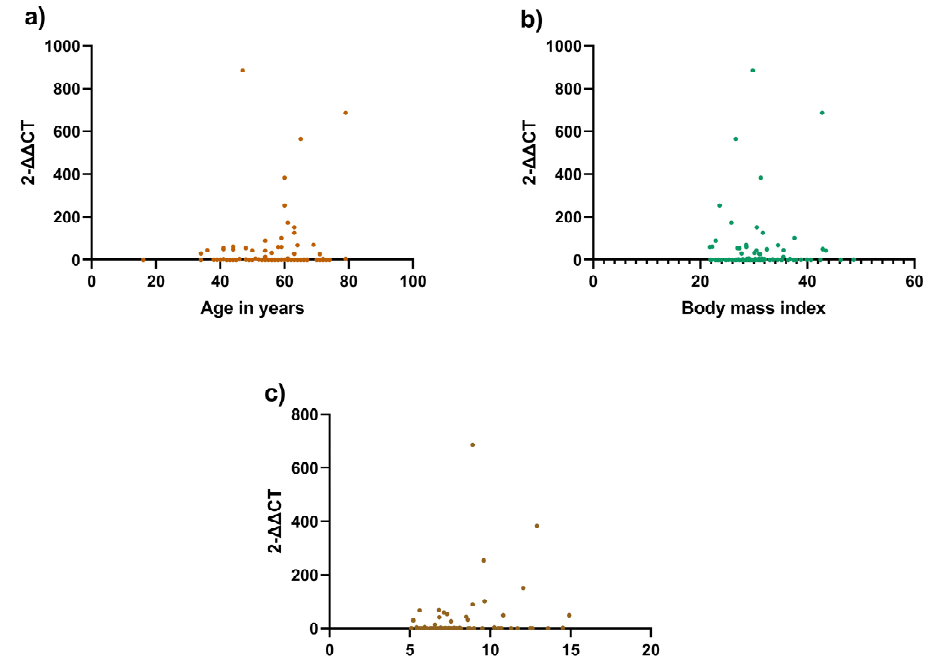
Table 3. Correlation analysis between telomere length and clinical variables.